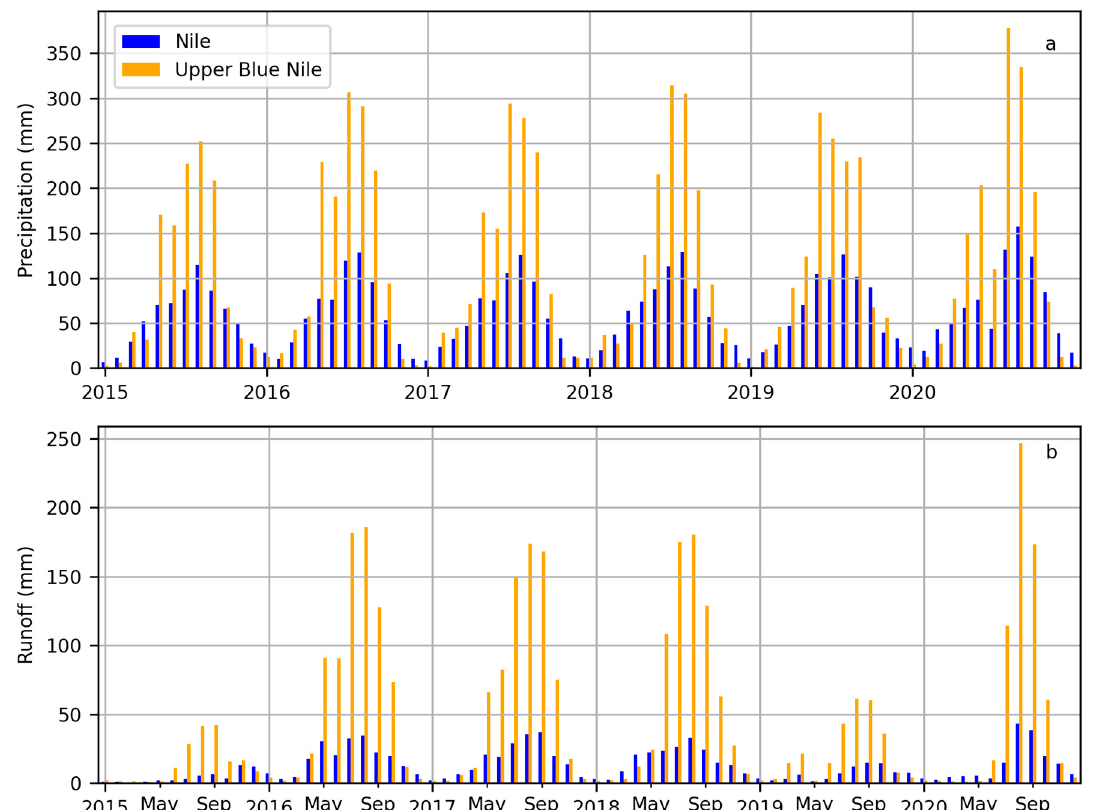
Figure 6. ( a , b ) Time-series of precipitation from Global Precipitation Measurement Mission (GPM) data. Figure ( b ) shows the time-series of runoff from the global land data assimilation system (GLDAS). Both figures represent spatially average monthly accumulated values for the corresponding watersheds.